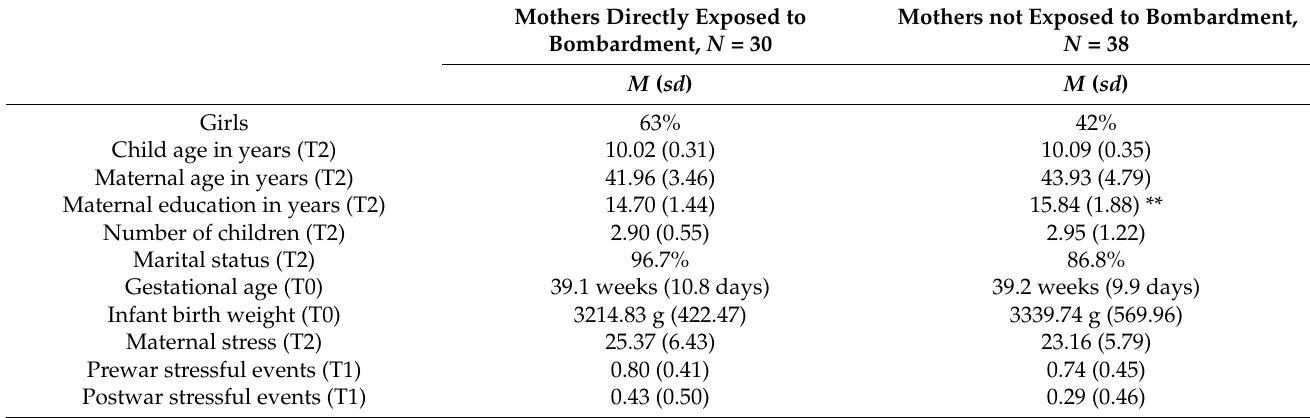
Table 1. Descriptives of the